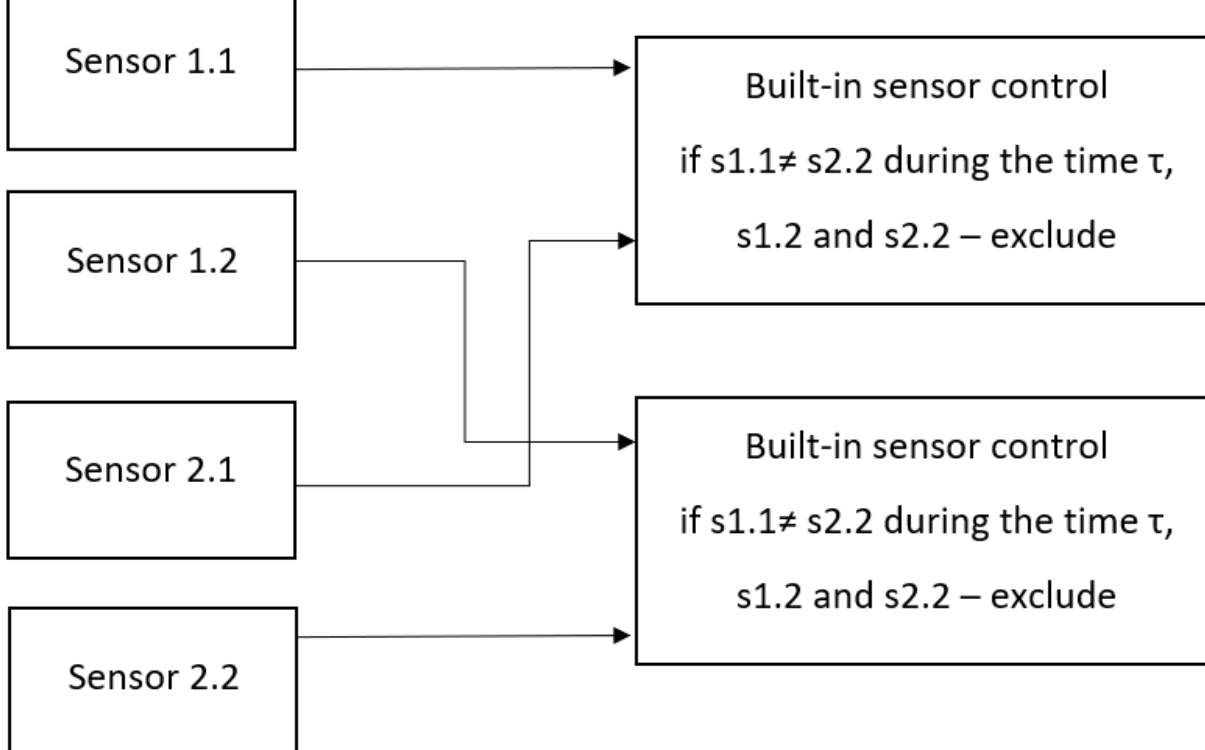
Figure 7. Block diagram of the built-in control of IPS.